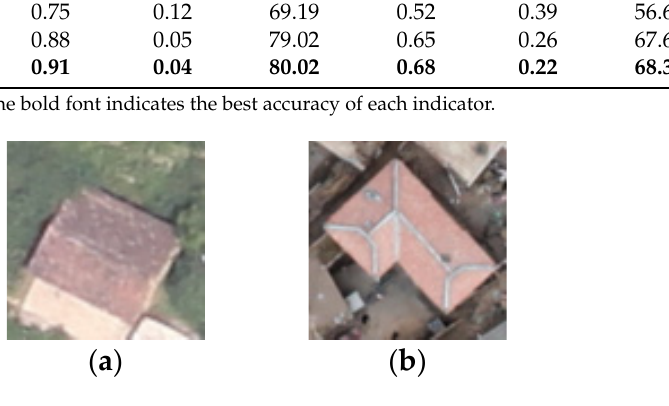
taset. The reason for this is that there were much smaller scales of Yushu dataset images than Ludian dataset images. It was also shown that in the refined assessment of building damage, the number of samples can have a significant impact on the accuracy of the as- sessment. However, the accuracy of the model was improved dramatically when the network trained using Ludian images was fine-tuned using a small additional amount of Yushu images. As shown in Table 11, the OA was 95.86%, 80.82%, and 68.33% for the three groups, respectively, which was 7.56% and 1.14% higher for Group 1, 10.83% and 1% for Group 2, and 11.7% and 0.71% for Group 3, compared to Tests 1 and 2, respectively. This is because the historical earthquake data can provide the basic features of the damaged buildings. By adding a small number of images from the testing area, more detailed and local features can be learned, bringing about the improvement of classification accuracy. This indicates that fine-tuning is an effective strategy for the classification of building damage Through the visual qualitative analysis of the prediction results of some areas, we can intuitively understand the model through the assessment of building damage. In this study, we divided the images into patches, rather than segmentations of individual build- ings. Therefore, a patch may contain several buildings. When a building was cropped into two or more patches, the damaged features of the building were retained in the corre- sponding patches. The EBDC-Net model trained using the Ludian dataset was fine-tuned using the Yangbi dataset. Figure 8 shows the visualization results of the model evaluation and the visual interpretation results (ground truth). The model evaluation results were generally consistent with the visual interpretation results, with an overall accuracy of 75%,